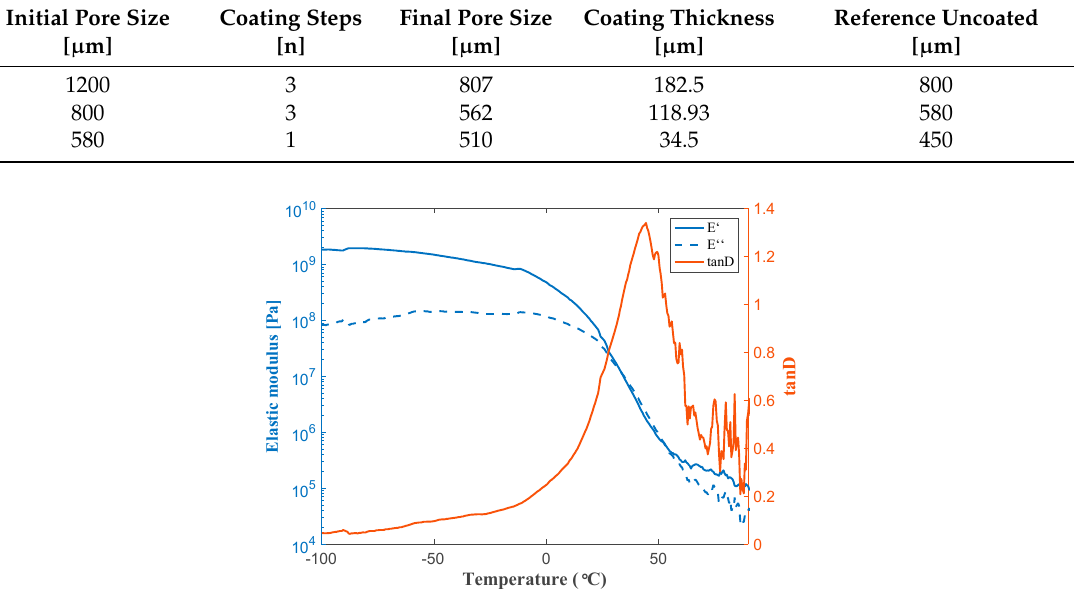
Figure 5. DMA measurements for solvent-based paint system.